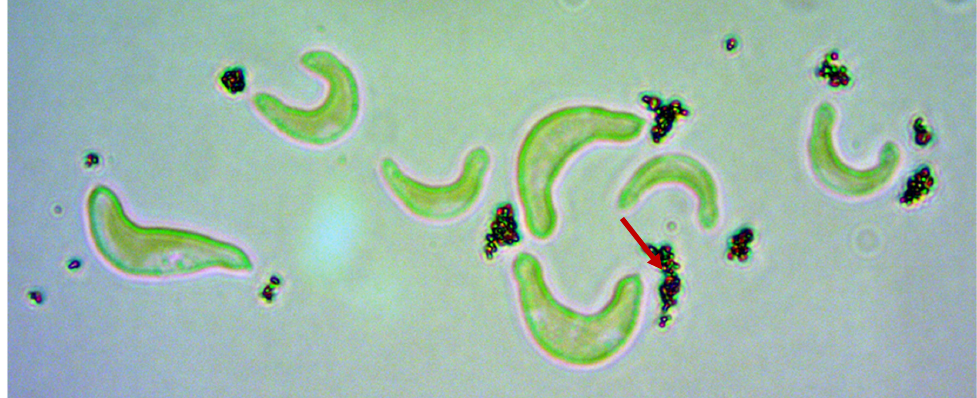
Figure 3. Nanoparticle attachment to transparent, sheath-like structures around algal cells (red arrow). This phase-contrast image (1000× magnification) was captured after 3 h incubation with 100 mg/L CeO 2 NM-213.